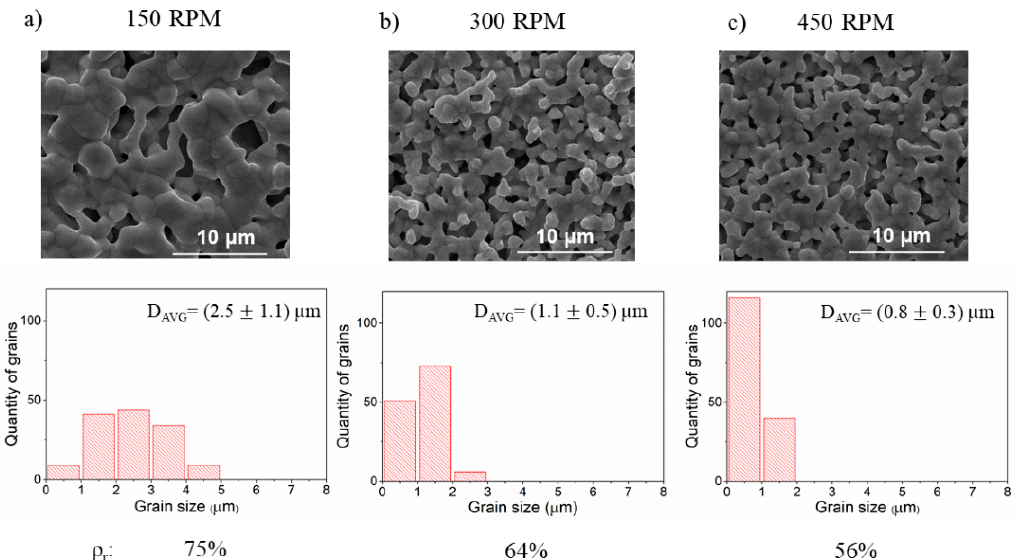
Figure 4. The SEM images of the BLCF pellets obtained during reactants milling with different angular velocities. Underneath each micrograph, an individual grain size distribution with corresponding relative density value ( ρ r ) is shown. ( a – c ). In the last test, the number of milling cycles, and therefore the total time of milling, has been doubled. The results of the SEM evaluation are given in Figure 5. Extended milling time significantly increases relative density, which results in the highest value of all three